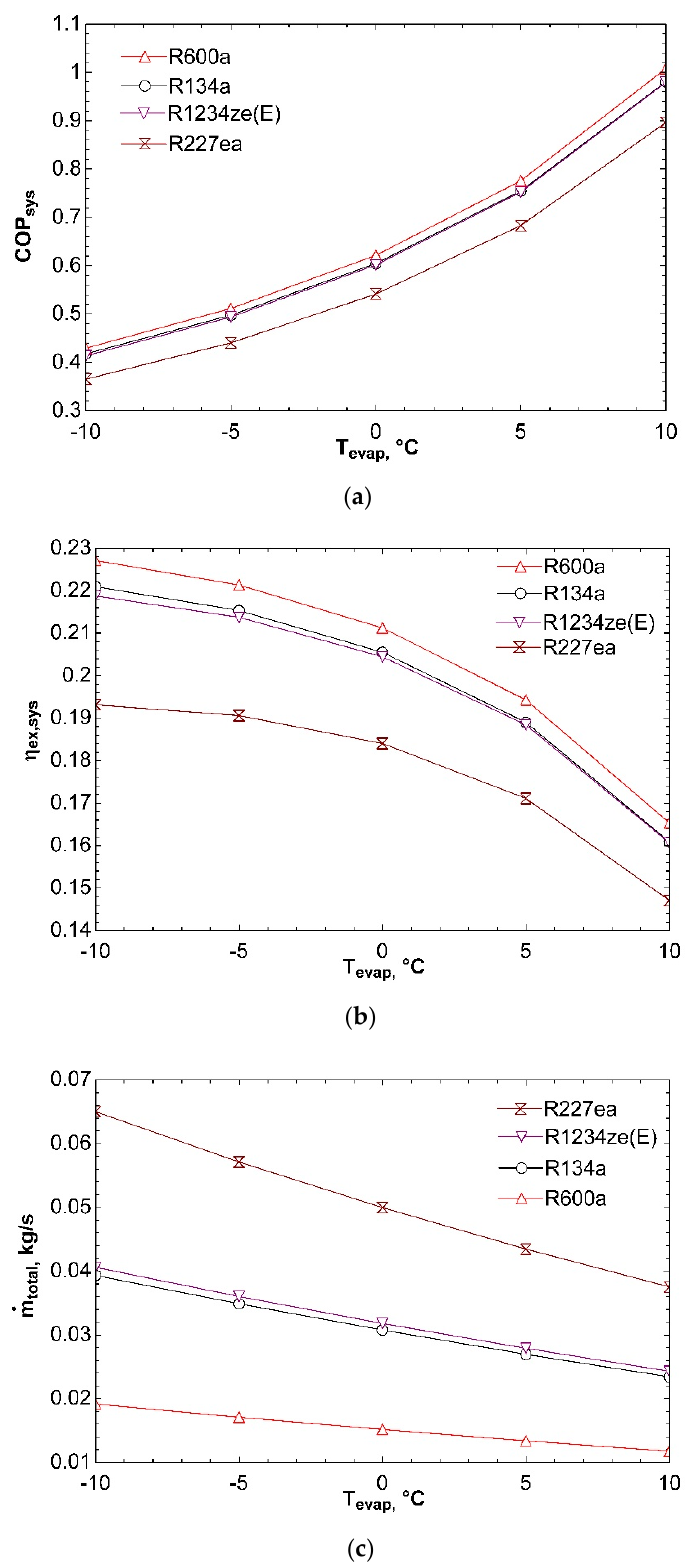
Figure 3. Effect of T evap on COP sys ( a ), ƞ ex,sys ( b ), and ṁ total ( c ) in combined ORC-single evaporator VCR Figure 3. E ff ect of T evap on COP sys ( a ), η ex,sys ( b ), and ˙m total ( c ) in combined ORC-single evaporator cycle. VCR